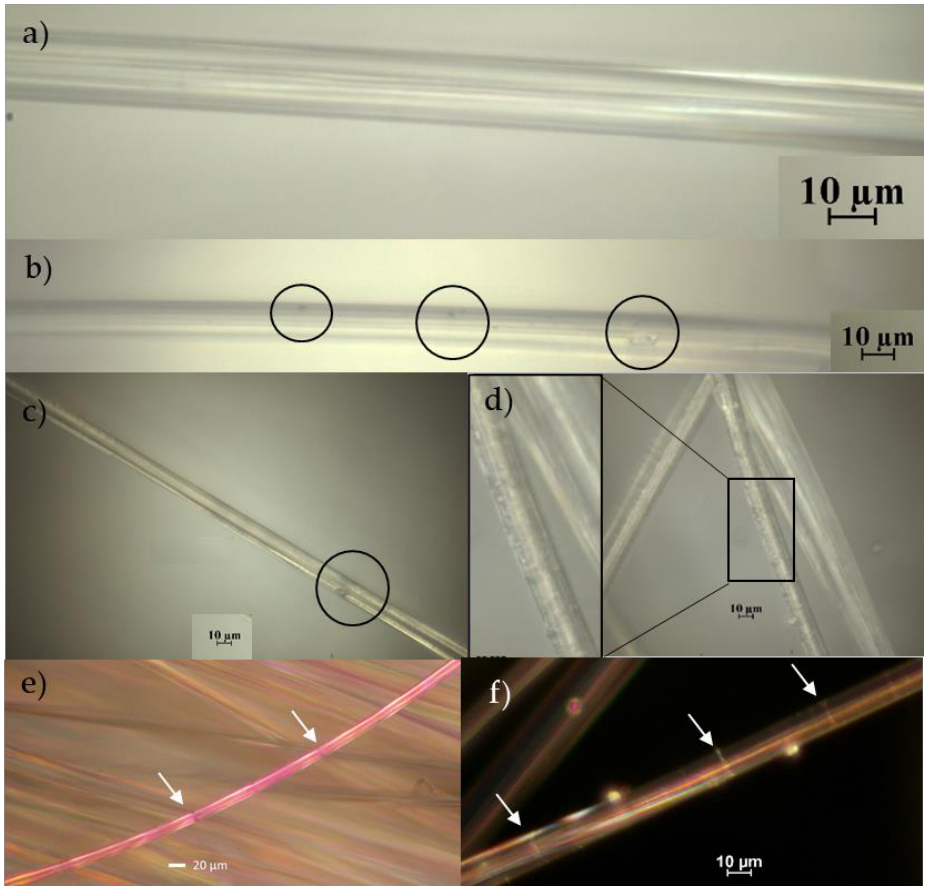
Figure 7. Optical micrographs for virgin ( a , b , e ) and treated fibers ( c , d , f ). Images ( e ) and ( f ) are for fibers within tested tows. The treated fibers are taken from the inner part of the bundle to facilitate examining the bare surfaces of fibers rather than the coating.